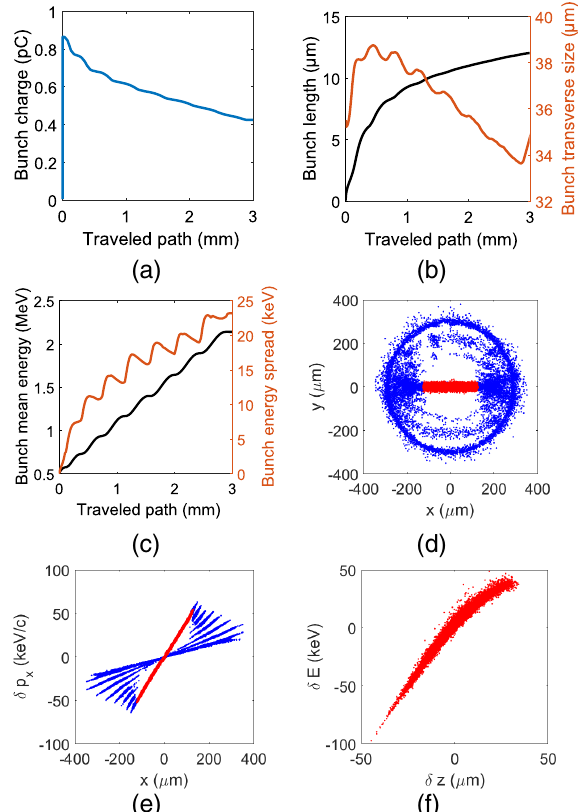
FIG. 8. Acceleration of 1 pC photoemitted bunch in the high energy THz gun: (a) bunch charge, (b) size, and (c) energy in terms of traveled path and (d) shape, (e) transverse phase space, and (f) longitudinal phase-space 3 mm from gun exit are depicted (red dots: output particles; blue dots: trapped particles).